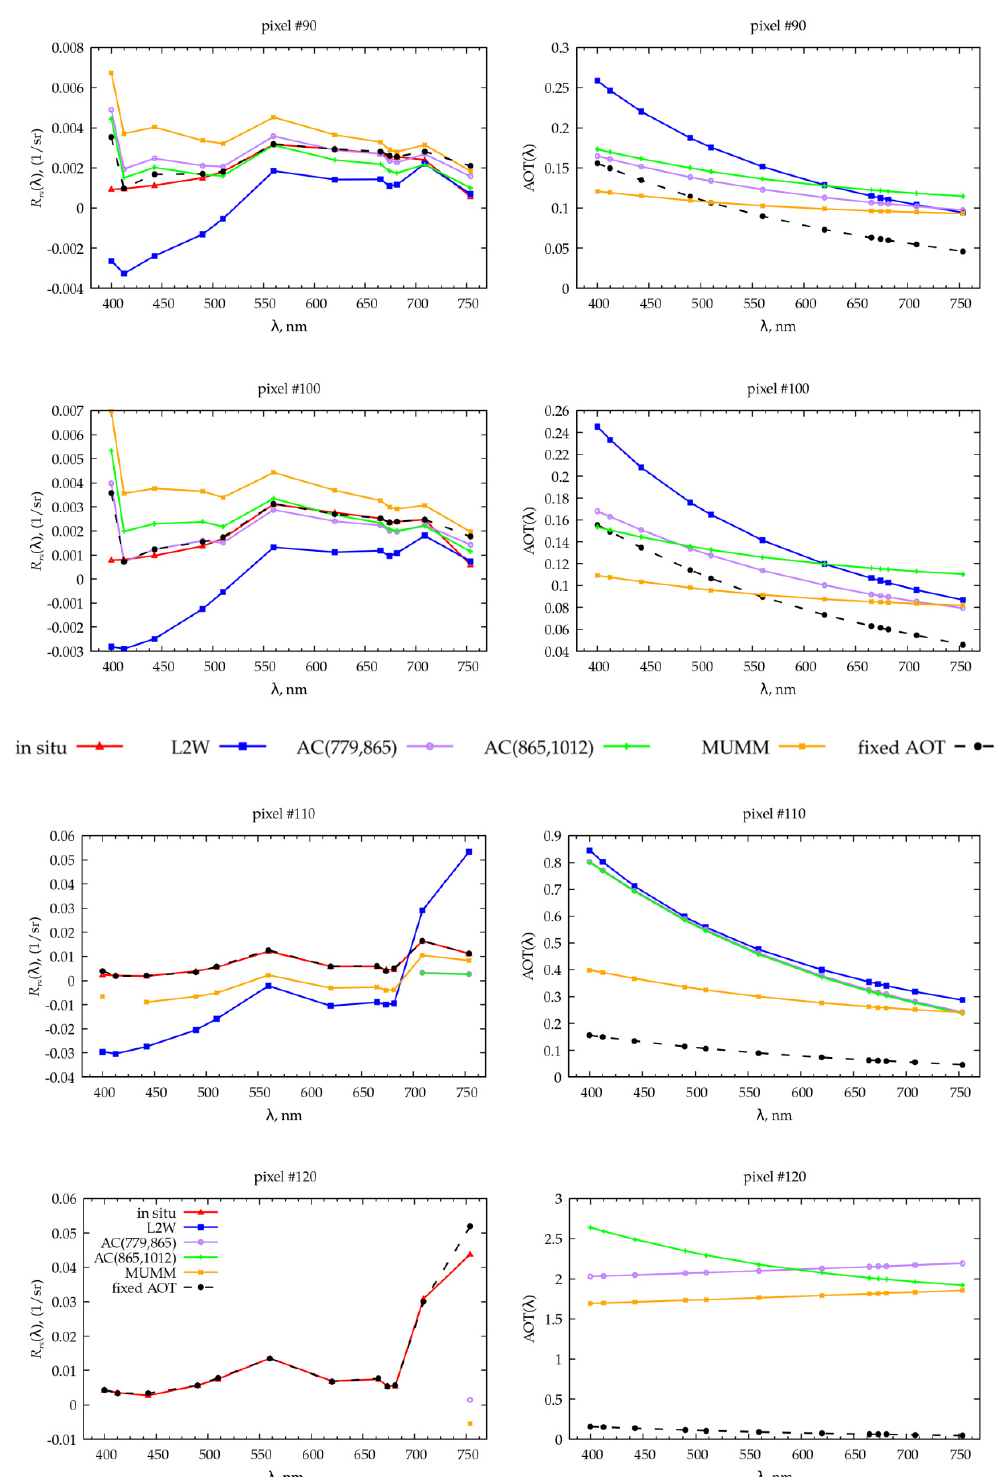
Figure 14. Spectral variations of R rs (on the left) and AOT (on the right) in selected pixels along the motorboat route. The colored lines show the spectra retrieved by different atmospheric correction algorithms: L2W (blue line), ac(779, 865) (magenta line), ac(865, 1012) (green line), MUMM (orange line), and fixed AOD (black dashed line). The red lines are in situ R rs . The number of match-ups is 127.